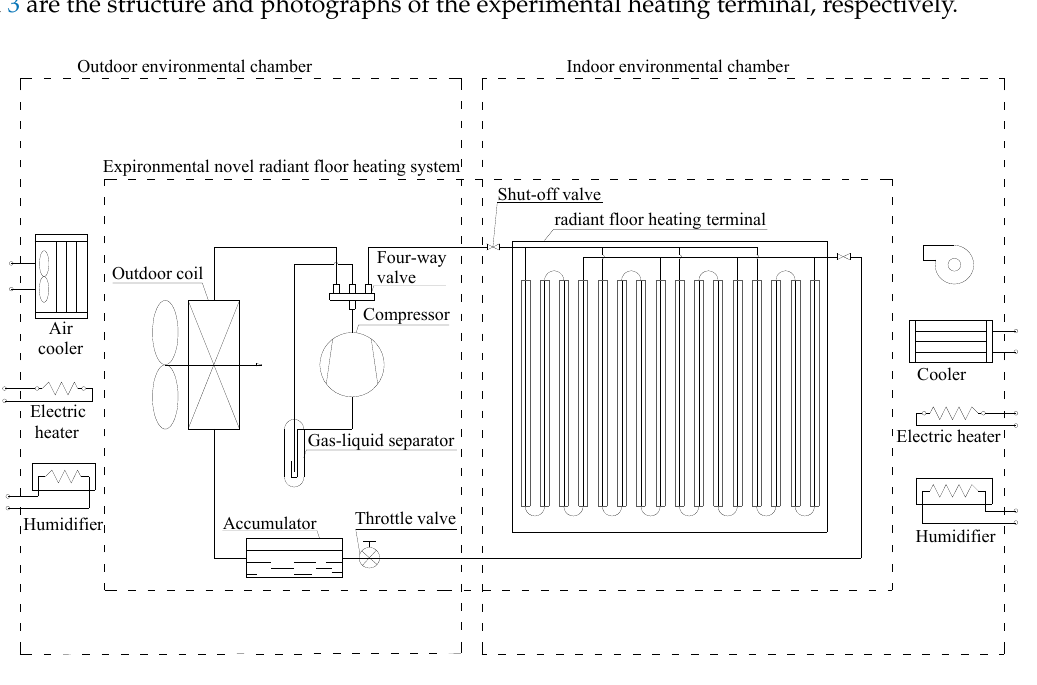
Figure 1. Schematic of the experimental platform and the novel air-source heat pump (ASHP) heating system.